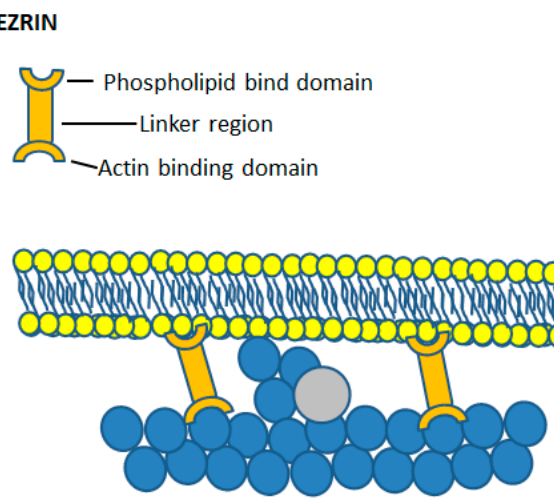
Figure 4. Ezrin crosslinking actin and the plasma membrane. The upper cartoon of an ezrin molecule shows the three main features—the phospholipid binding domain, the actin-binding domain and the linker region between the two. Beneath this is an illustration depicting the effect of ezrin crosslinking on the ability of actin to polymerise. With ezrin binding the cortical actin network to the plasma membrane, Brownian fluctuations in the plasma membrane are locally prevented and actin polymerisation cannot occur. In this way, ezrin binding stabilises cell surface structures such as villi and neutrophil wrinkles.